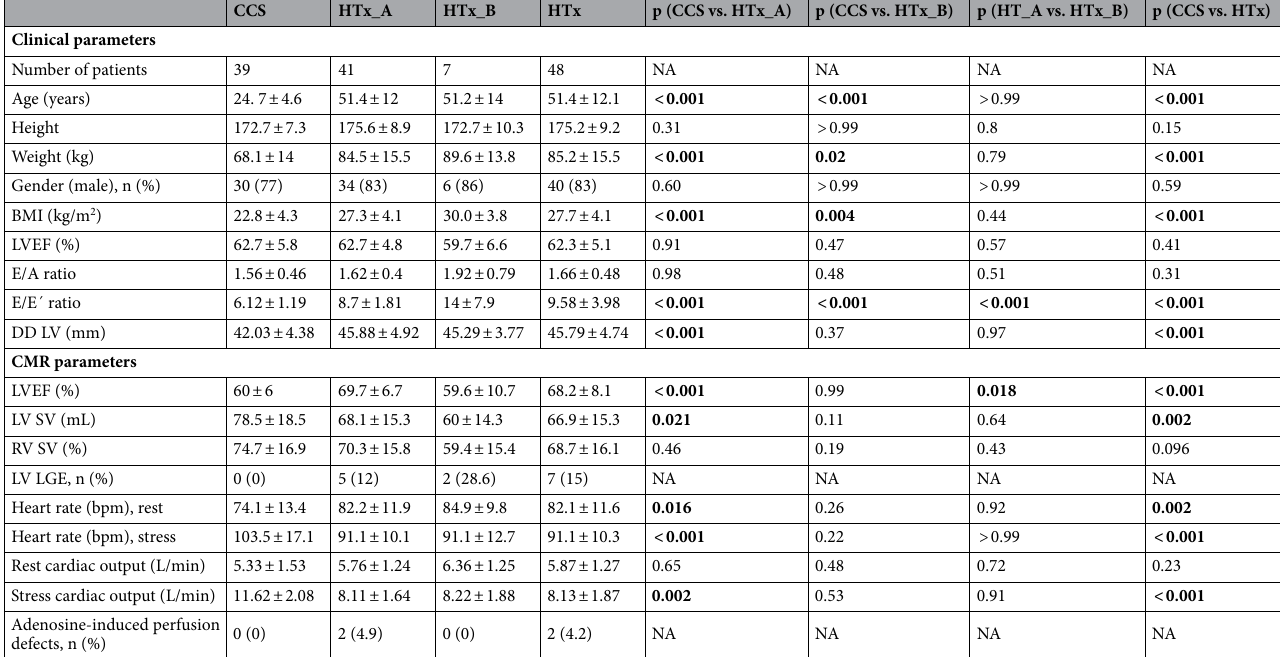
Table 2. Baseline clinical, TTE and CMR parameters. Values are presented as mean ± SD unless otherwise indicated. Statistically significant p values are in bold. BMI body mass index, LVEF left ventricular ejection fraction, LV SV left ventricular stroke volume, DD LV left ventricular diastolic diameter, RV SV right ventricular systolic volume, LV LGE left ventricular late gadolinium enhancement, TTE transthoracic echocardiography, CMR cardiovascular magnetic resonance, CCS childhood cancer survivors, HTx heart transplant group, HTx_A heart transplant without diastolic dysfunction subgroup, HTx_B heart transplant with diastolic dysfunction